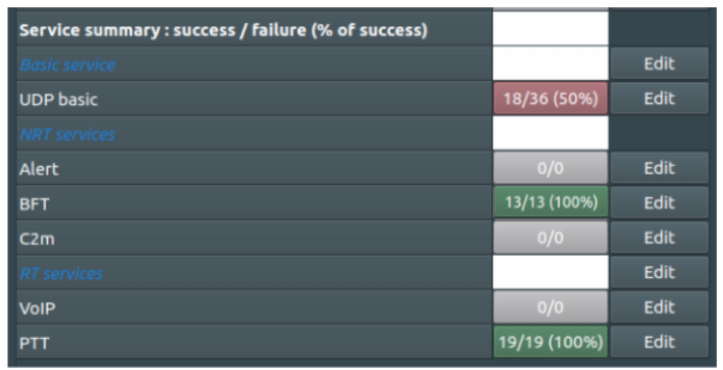
Figure 22. Summary of services successful realization.